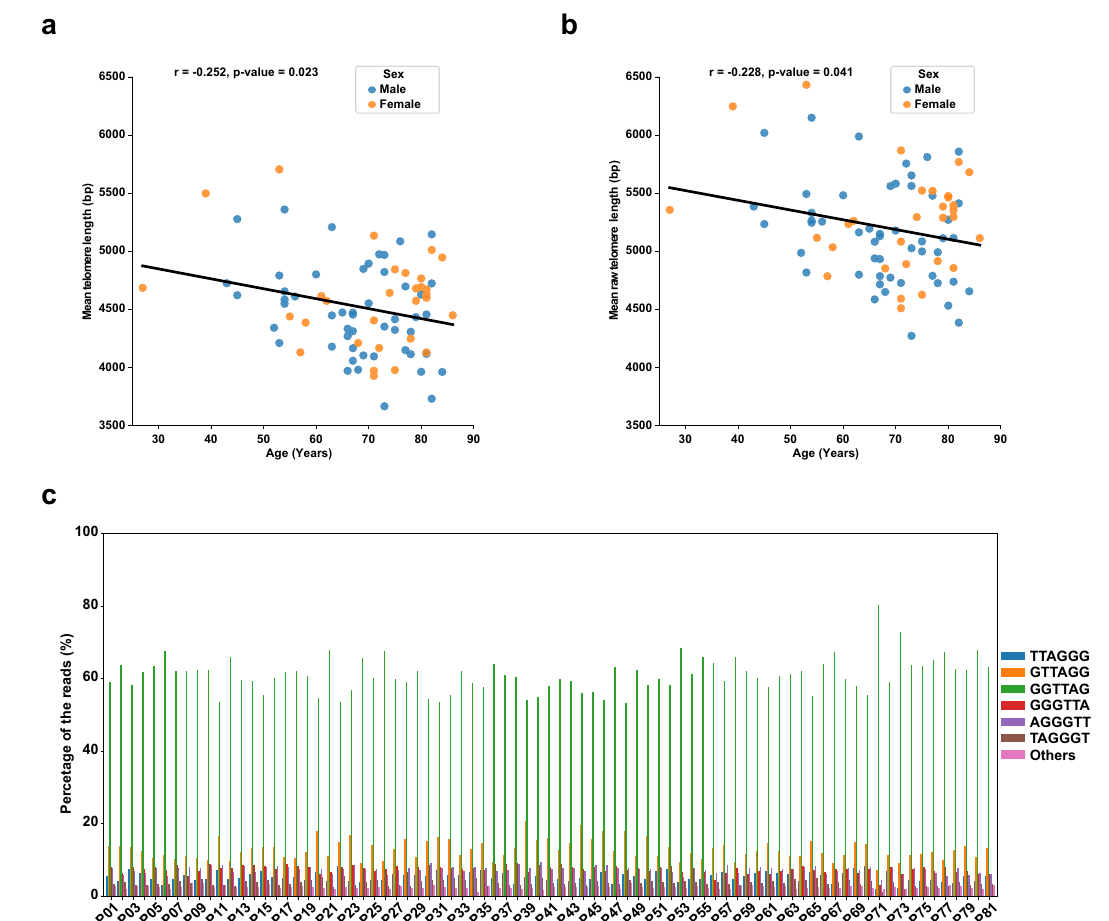
Fig.3|High-throughputtelomerelengthmeasurementinpatientPBLsamples. a Mean telomere length distribution of patient PBL samples shows age-dependent shortening as expected. Pearson correlation coef fi cient (two-sided) was used to measure the correlation between mean telomere length and age ( r = − 0.252; p - value=0.023). Source data are provided in Source Data 2. b Mean raw telomere length distribution of patient PBL samples shows age-dependent shortening as